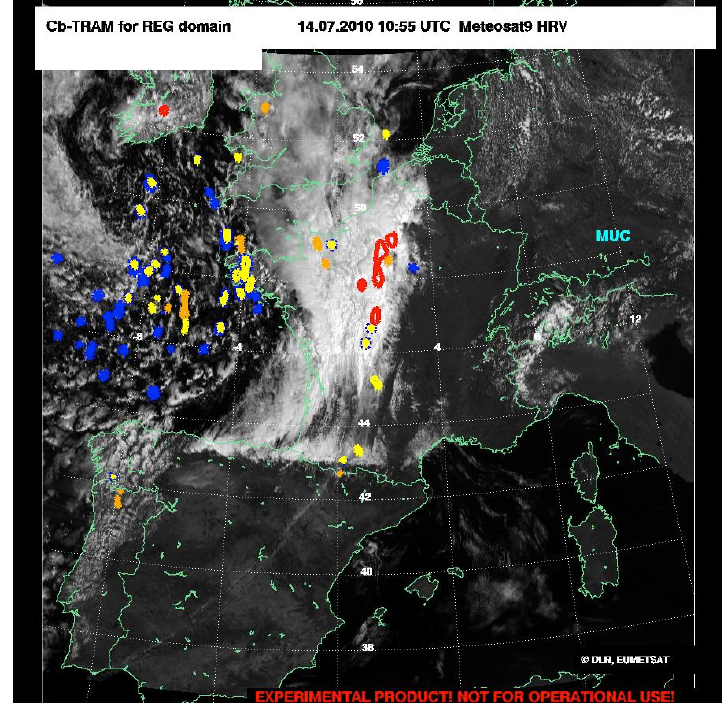
Fig. 4. Example of the test domain and Cb-TRAM for 14 July 2014. Yellow structures are CI objects detected by the new algorithm; blue structures are objects detected by the previous algorithm. Red and orange are the rapid-development and mature Cb objects,